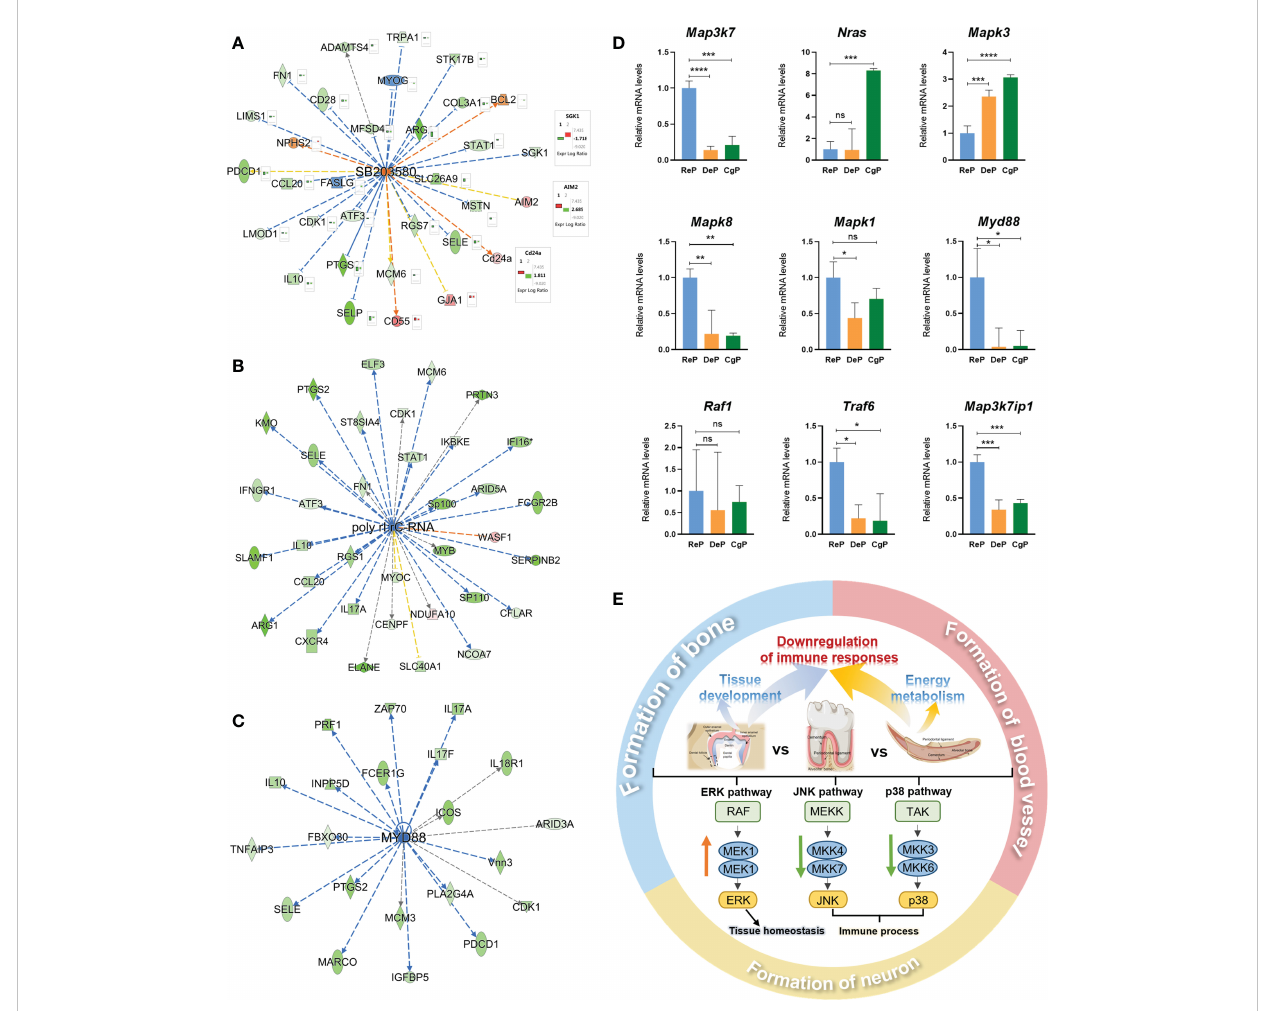
FIGURE 6 Prediction of upstream regulators and validation of target genes. (A – C) Network diagram representing the upstream regulators with highest and lowest z-scores. (D) mRNA expression of 9 representative genes was validated using RT-qPCR. *P < 0.05, **P < 0.01, ***P < 0.001, ****P < 0.0001. (E) Schematic diagram of active remodeling periodontal tissue characteristics. ns, no signi fi